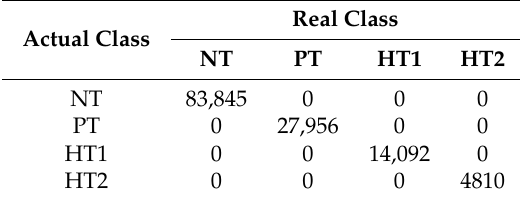
Table 4. The confusion matrix for Random Forest over the Training Set.